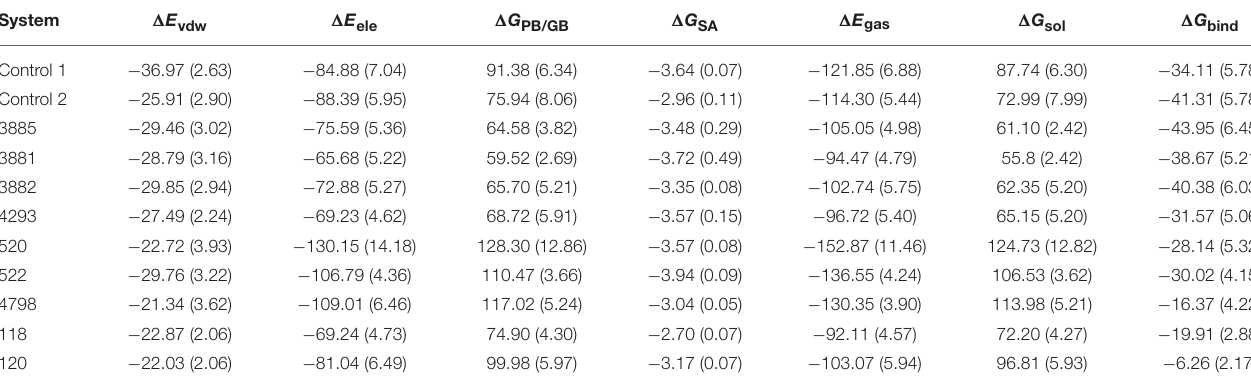
TABLE 3 | Contributions of various energy components to the binding free energy (kcal/mol) for the studied inhibitor with HPPD a .